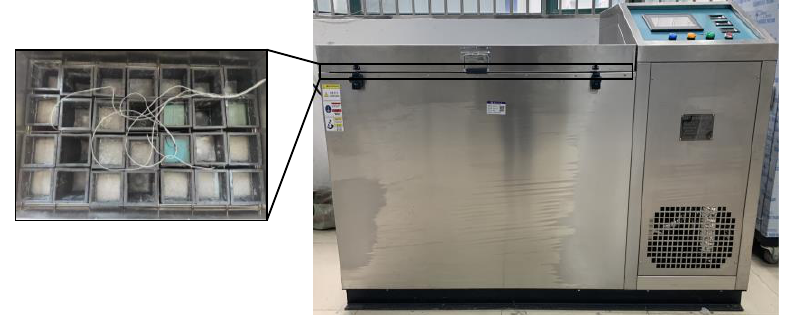
Figure 2. Fast freeze – thawing test.